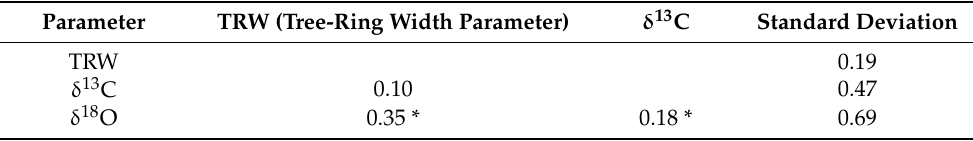
Table 1. Correlation between ancient Douglas fir ring chronologies for the common interval of 228 years. Asterisk marks a significant correlation at p < 0.005. Parameter TRW (Tree-Ring Width Parameter) δ 13 C Standard Deviation TRW